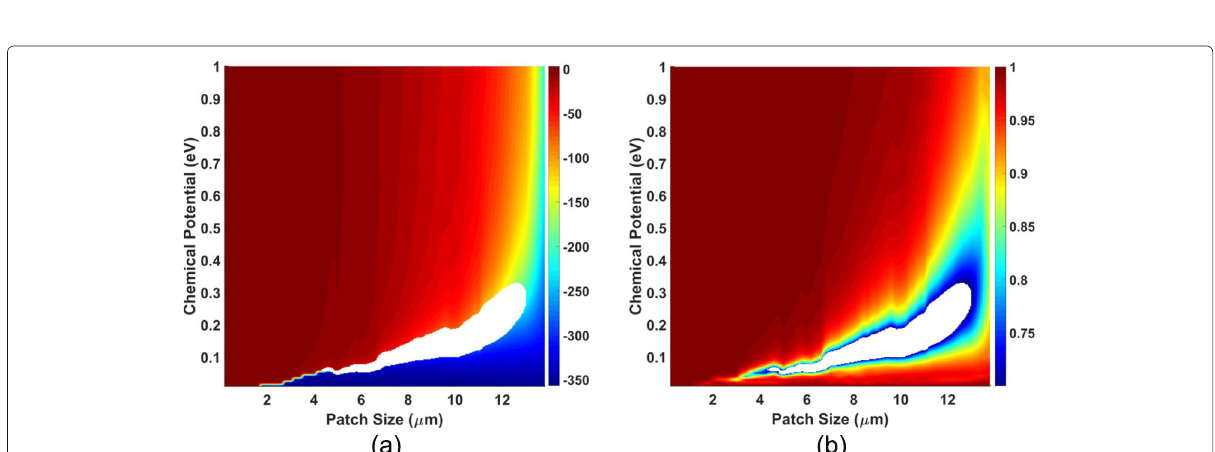
Fig. 2 Calibration diagram of reflection coefficients of the graphene cell. The reflection coefficient of the graphene cell influenced by the graphene patch size w x and the chemical potential μ c , where the region where the magnitude of reflection is smaller than 0.7 is subtracted. a phase and b magnitude